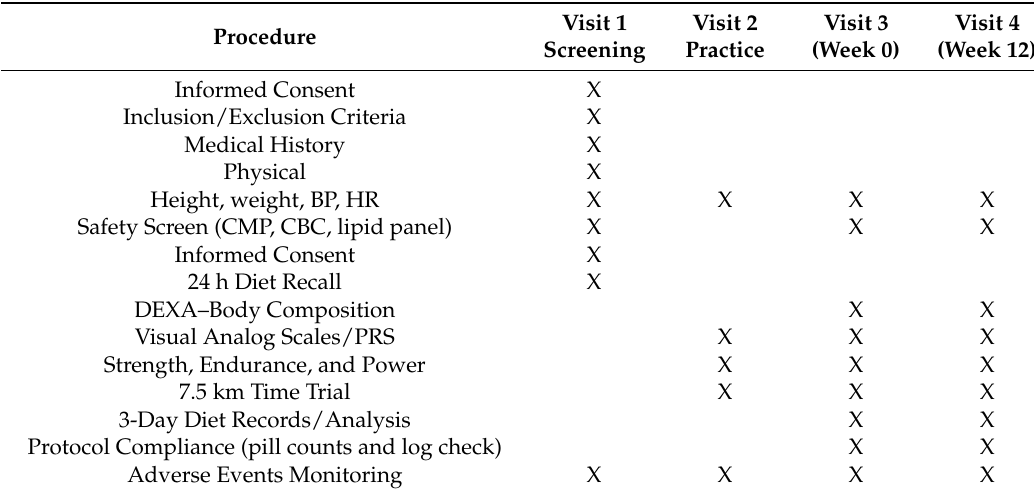
Table 1. Overview of research